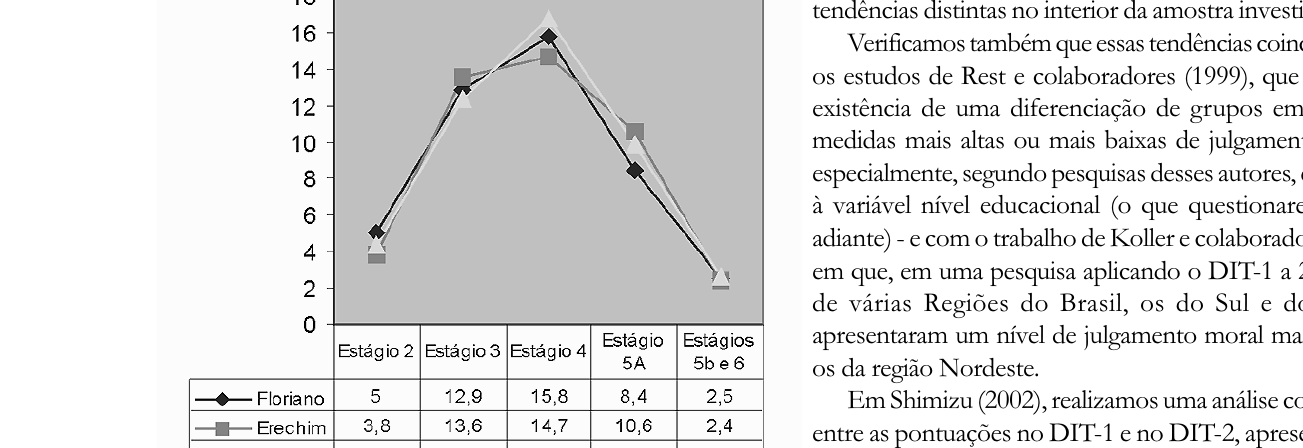
A: os pesquisandos de Floriano/PI apresentaram maior